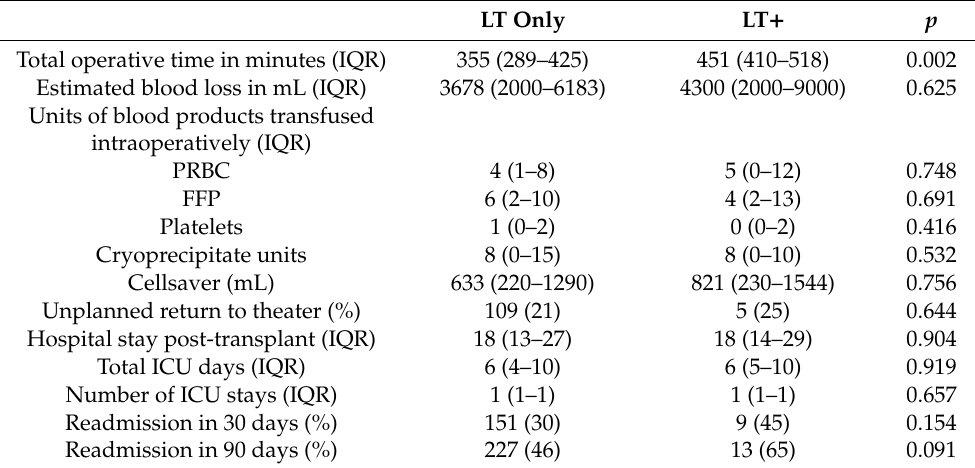
Table 4. Surgical